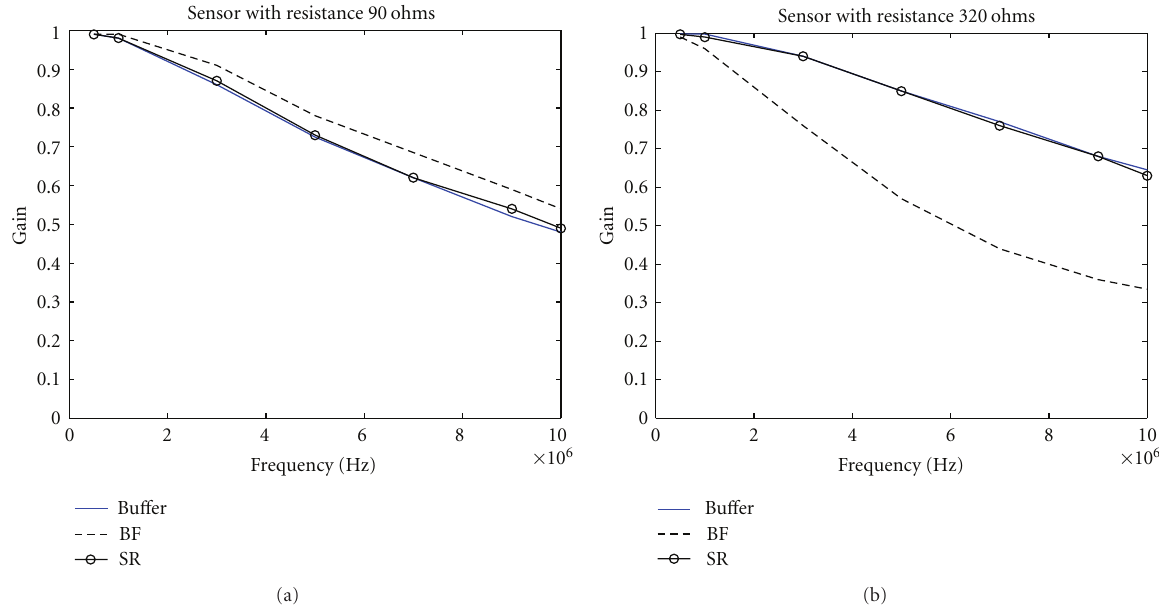
Figure 6: (a and b) The gain versus frequency plot for the sensor detecting the DNA nonhybridization process. It can be observed that the gain of the nonhybridized sensor is similar to the original (bu ff er or base). Each graph represents a sensor with di ff erent